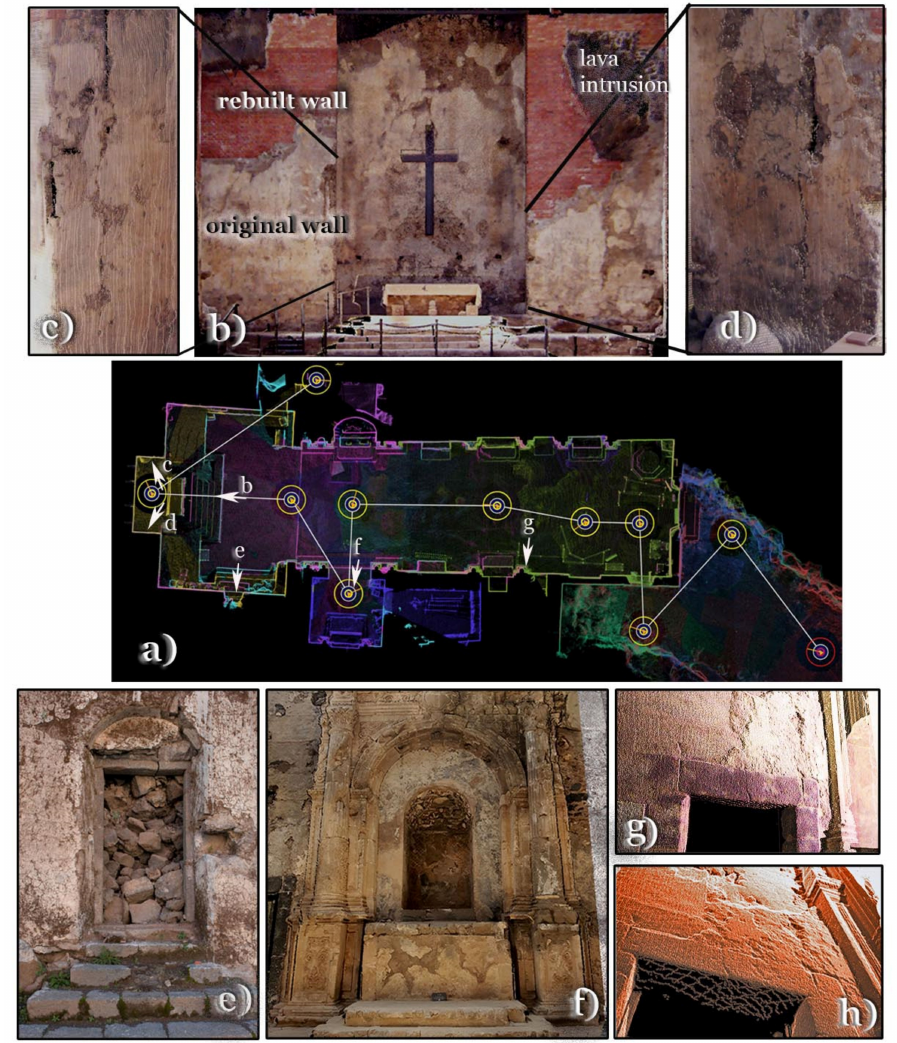
Figure 6. Acquisition phase with TLS: ( a ) plan of the church; the circles indicate the TLS measurement points, and the acquisition was performed from outside to inside the building (Traverse mode); ( b ) point cloud of the altar area; it is still possible to observe the consistency of the original wall, the reconstructed portion (red bricks) and the lava intrusion; ( c , d ) details of the vertical fractures; ( e ) southern door of the presbytery closed by stones (2012’ photo by R. Azzaro); ( f ) Crocifisso Altar, the burnt dark materials are still visible; ( g , h ) views of fractured lintel on the entrance door to the